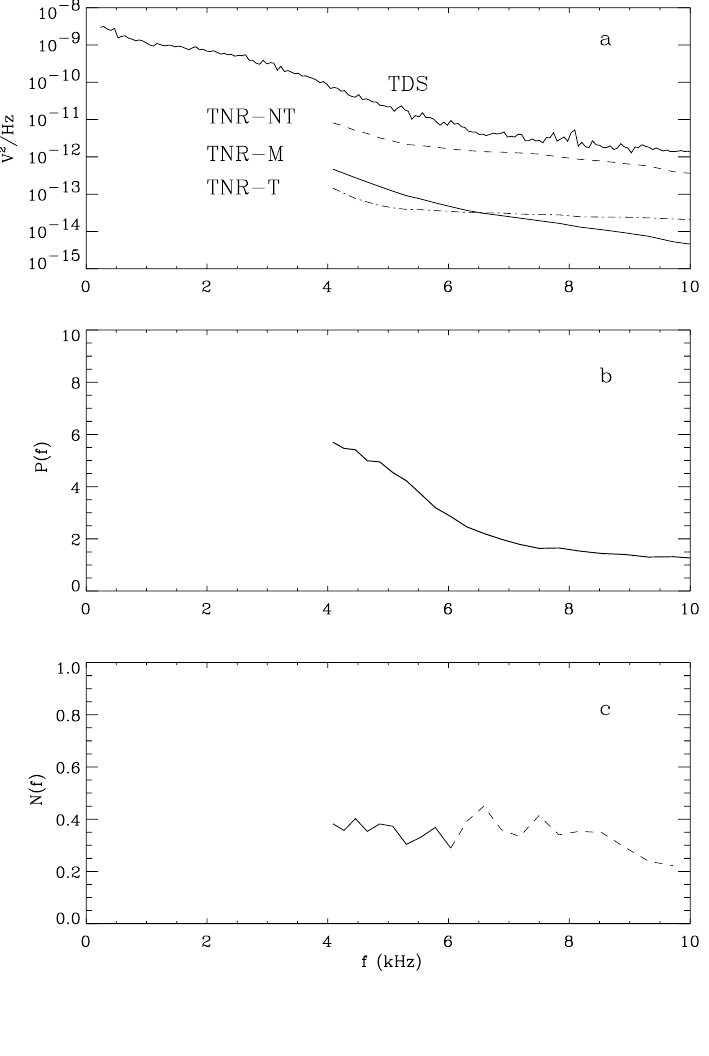
Fig. 5. (a) The upper line is the average spectrum of the 2160 coherent electro- static waves detected by TDS from 20 May to 26 June 1995. NT is the non- thermal TNR spectrum averaged over the sample of non-thermal spectra; T is the thermal spectrum averaged over the sample of thermal spectra. The solid line M is the total intensity of the non- thermal TNR spectra divided by the to- tal number of spectra, thermal and non- thermal; it is thus a time average of the non-thermal spectral energy. (b) Aver- age over 38 days of the percentage of non-thermal spectra (Eq. 2), as a func- tion of the frequency. (c) the rate of oc- currence as a function of the frequency, in s − 1 (Eq. 3), of coherent electrostatic waves in the solar wind at